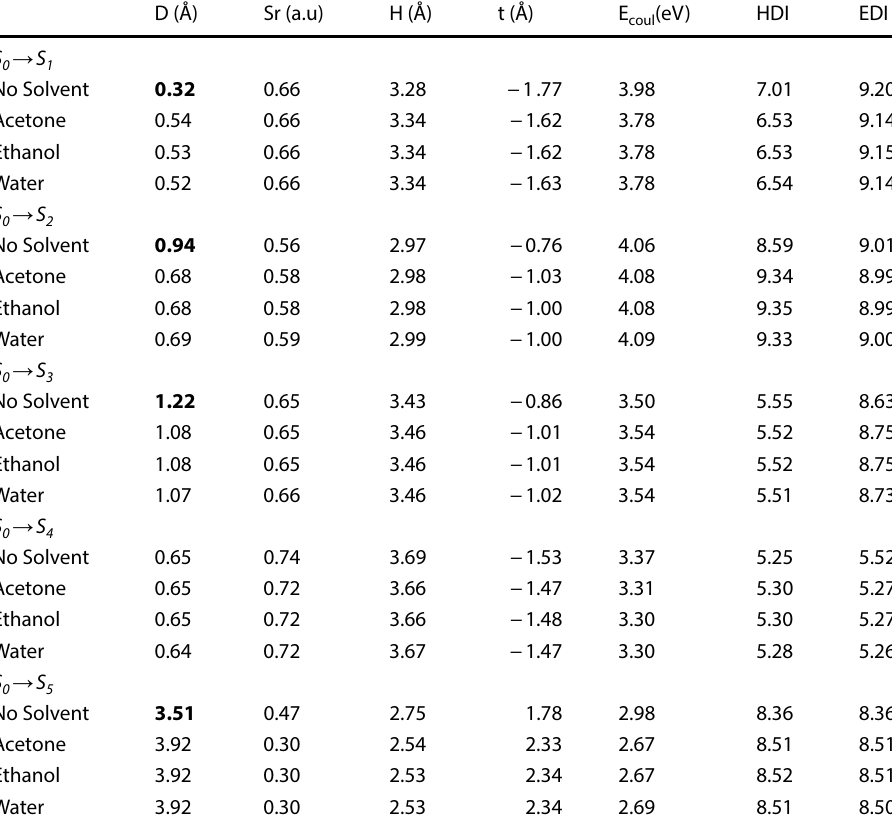
Table 2 Results from the excitation studies of cyanurated H-acid with aniline (CHA) in no solvent, acetone, ethanol and water using RB3LYP method with 6-31G (d,p) basis